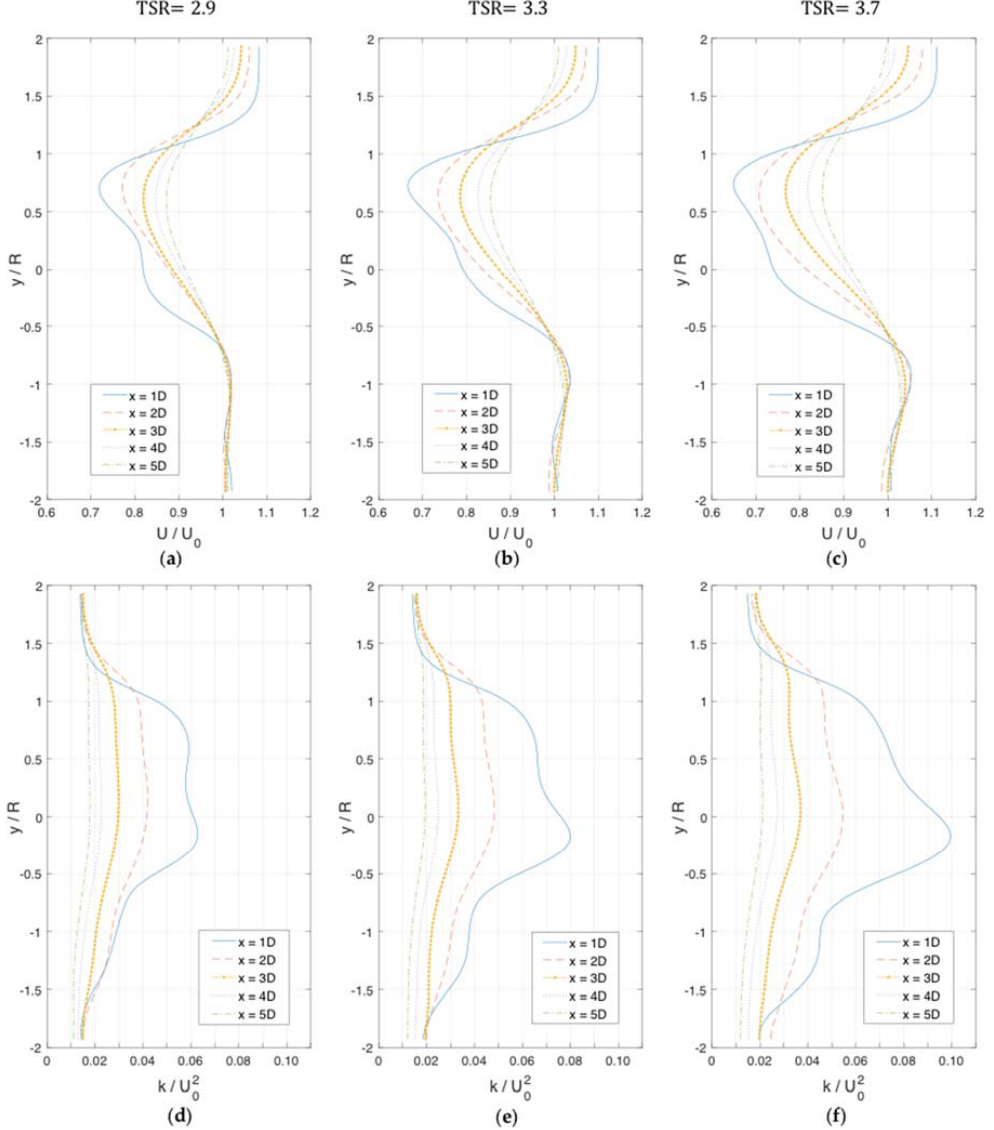
Figure 13. Horizontal profiles at mid-elevation of turbine z / H = 0: mean stream-wise velocity component ( a ) TSR = 2.9, ( b ) TSR = 3.3, ( c ) TSR = 3.7; and turbulence kinetic energy ( d ) TSR = 2.9, ( e ) TSR = 3.3, ( f ) TSR = 3.7 .